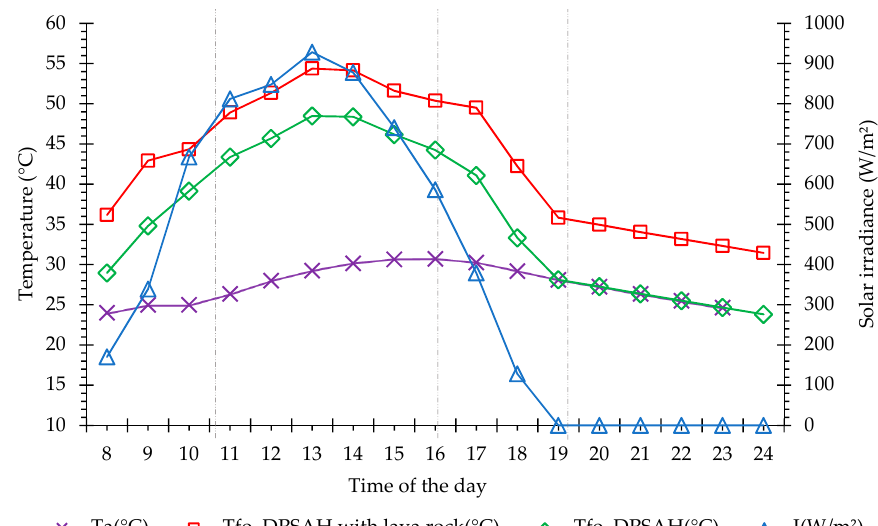
Figure 9. Solar Irradiance I, ambient temperature T a , and air output temperature Tfo against the time of the day for the conventional double-pass solar air heater (DPSAH) and DPSAH with lava rock.